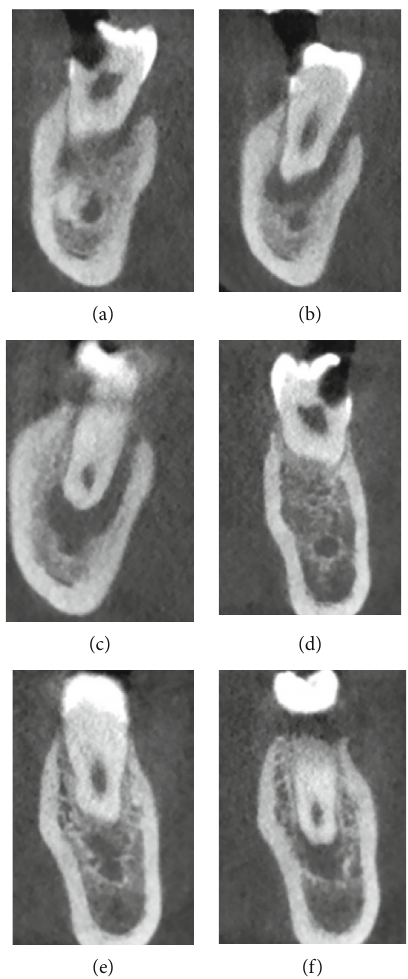
Figure 3: (a – c) Coronal section of #46 at cervical, middle, and apical thirds showing the presence of a single canal. (d – f) Coronal section of #36 at cervical, middle, and apical thirds showing the presence of a single canal.